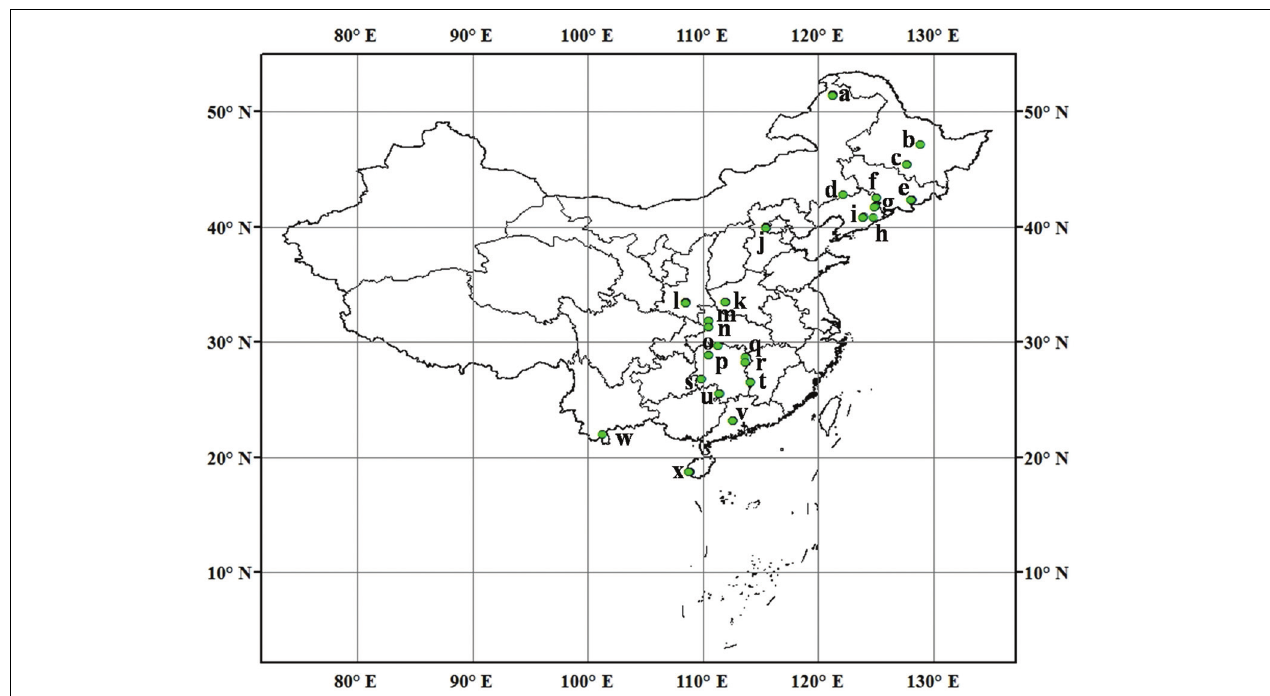
FIGURE 1 | Sampling locations and sample number in each location across North and South of Chinese forest soils. (a) Daxingan, 12; (b) Liangshui, 2; (c) Maoershan, 4; (d) Daqinggou, 2; (e) Changbaishan, 6; (f) Binglashan, 4; (g) Qingyuan, 5; (h) Baishila, 1; (i) Caohekou, 4; (j) Beijing, 12; (k) Baotianman, 9; (l) Qinling, 12; (m) Shennongjia, 3; (n) Huanglianba, 3; (o) Changde, 2; (p) Huaihua, 3; (q) Yueyang, 1; (r) Changsha, 2; (s) Huitong, 3; (t) Zhuzhou, 3; (u) Yongzhou, 3; (v) Dinghushan, 9; (w) Xishuangbanna, 1; (x) Jianfengling,